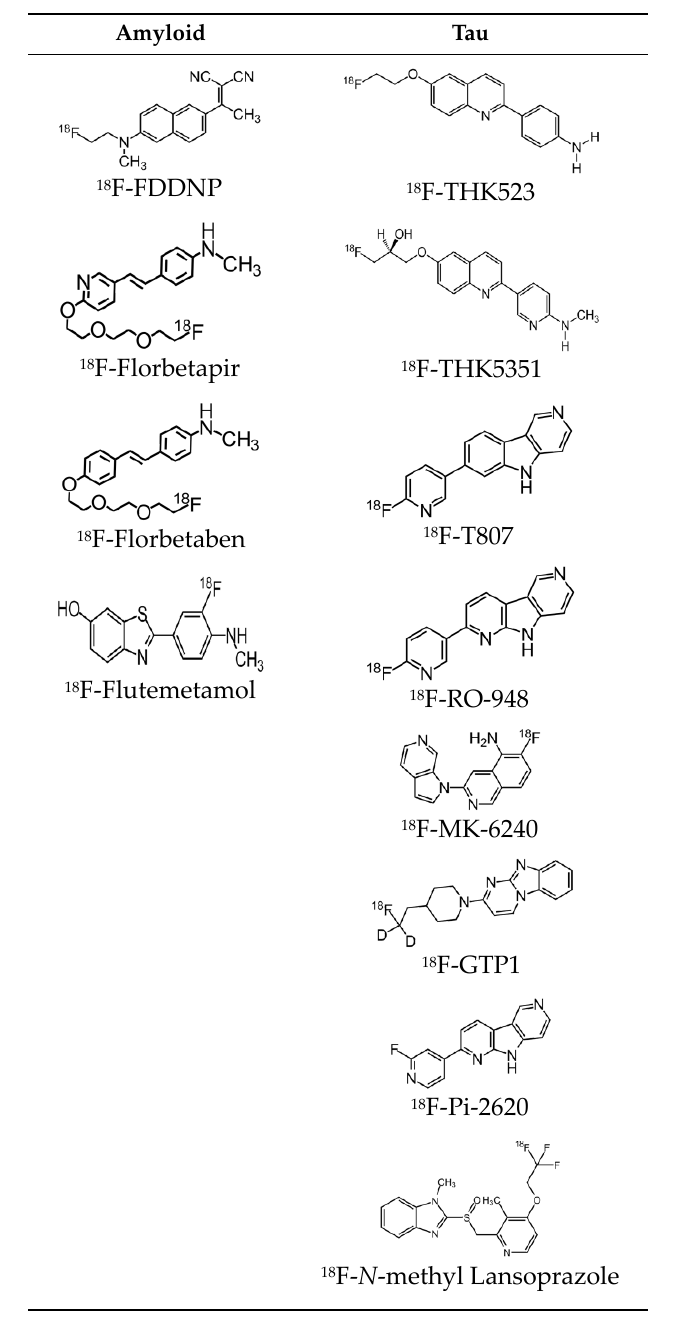
Figure 7. (18F)RO-948 PET images overlaid on MRI on a healthy control (upper row) and an AD patient (bottom row). The increased uptake of (18F)RO-948 in the AD patient is associated with the binding to the hyperphosphorylated tau protein. [80]. Images are reprinted with permission of the publisher [80]. Table 2. Molecular probes for the detection of Aβ or NFTs using PET.